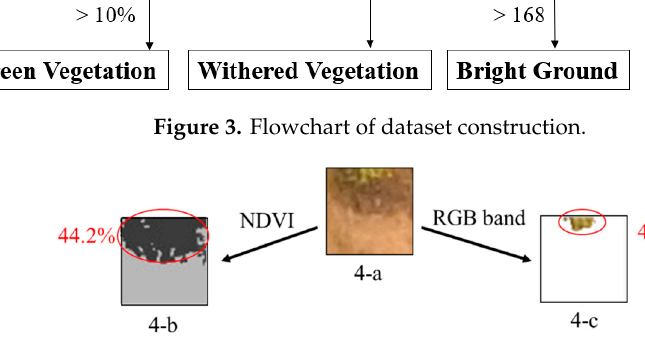
Figure 3. Flowchart of dataset construction.